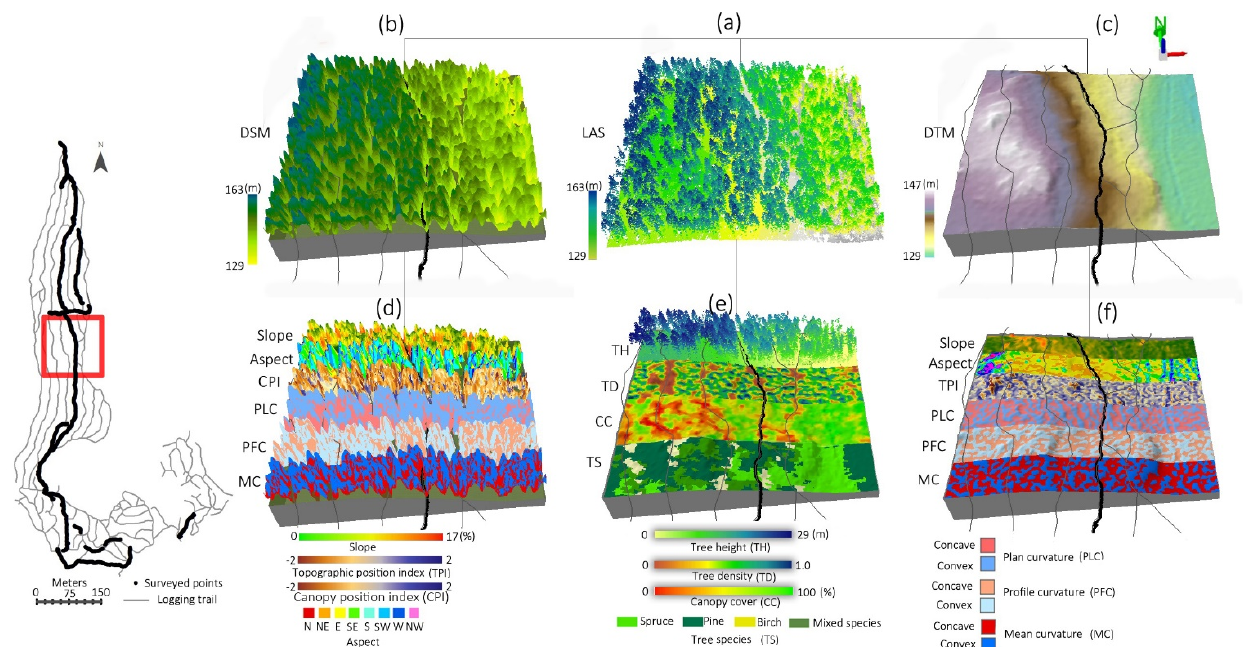
Figure 3. Object features in an example area of the study area. ( a ) 3D perspectives of high-density LiDAR point clouds, its metric derivatives including ( b ) the digital terrain model (DTM) and ( c ) digital surface model (DSM). ( d ) The ground-surface features were extracted from the DTM and ( e ) the canopy characteristics and ( f ) the canopy-surface features were extracted from the LiDAR points and the DSM, respectively.